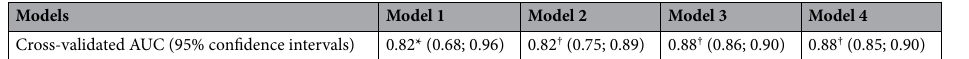
Table 3. Discriminative ability of Models 1–4. AUC Area under the curve. Model 1—Baseline biomarkers and clinical covariates. Model 2—Serially measured standard biomarkers (NT-proBNP, hs-TnT, eGFR) adjusted